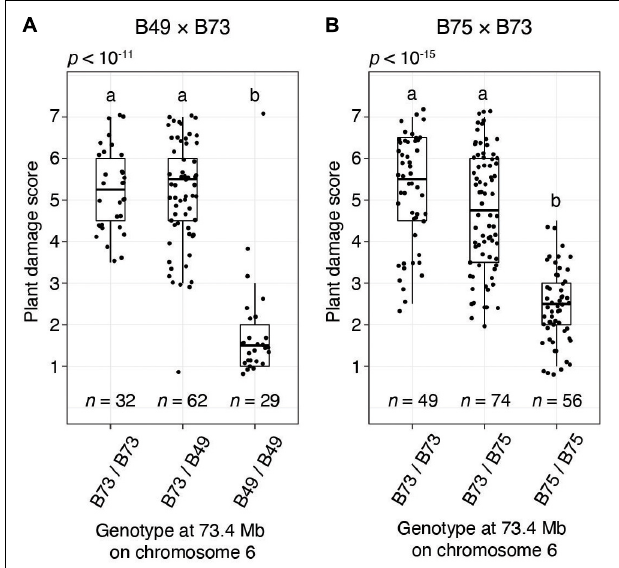
FIGURE 5 | The chromosome 6 T. urticae resistance QTL has a recessive mode of action in B49 and B75 as assessed in crosses to susceptible B73. Shown are boxplots with an overlay of data points for resistance to T. urticae strain W-GR as assessed with a plant damage score and classified by genotype at a locus at 73.4 Mb on chromosome 6 that is within the peak chromosome 6 QTL interval ( Figure 4 ). The data shown are from BSA replicate two of cross B49 × B73 (A) and BSA replicate one of cross B75 × B73 (B) . Data for all plants for which genotyping was successful in each replicate population are shown (i.e., not just the plants comprising the pools of phenotypic extremes used in BSA scans, Figure 4 and Supplementary Figures 2B, 3A ). Where significant variation was observed by ANOVA by cross ( p < 0.05), pairwise significance was assessed with correction for multiple testing using the Hochberg method (different letters denote significant differences at p <